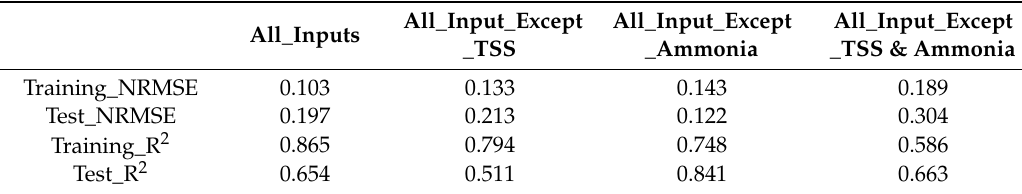
Table 4. Performance of the LR models based on the modified anaerobic digestion (AD) variables and di ff erent input vectors.